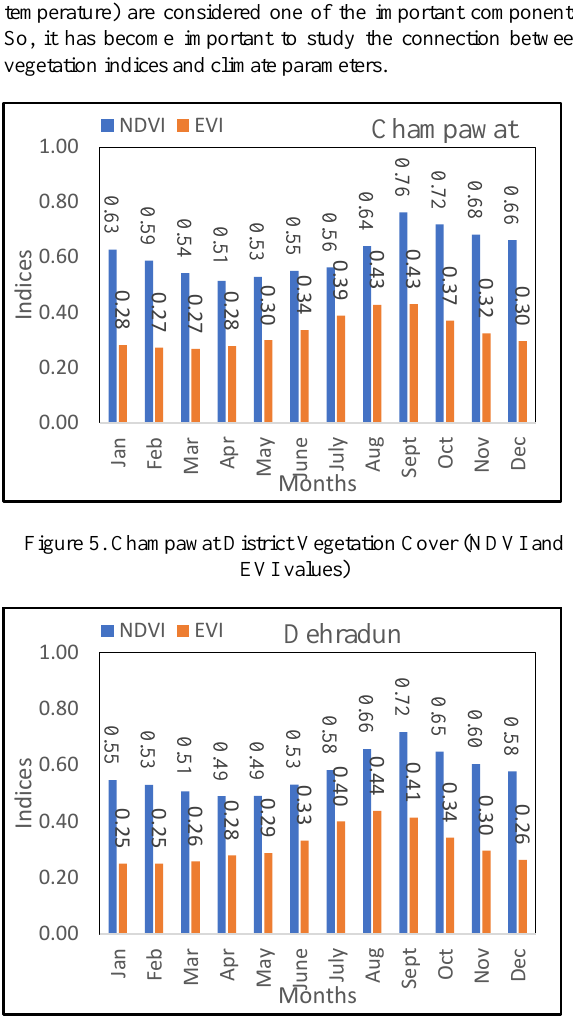
Figure 6. Dehradun District Vegetation Cover (NDVI and EVI values)